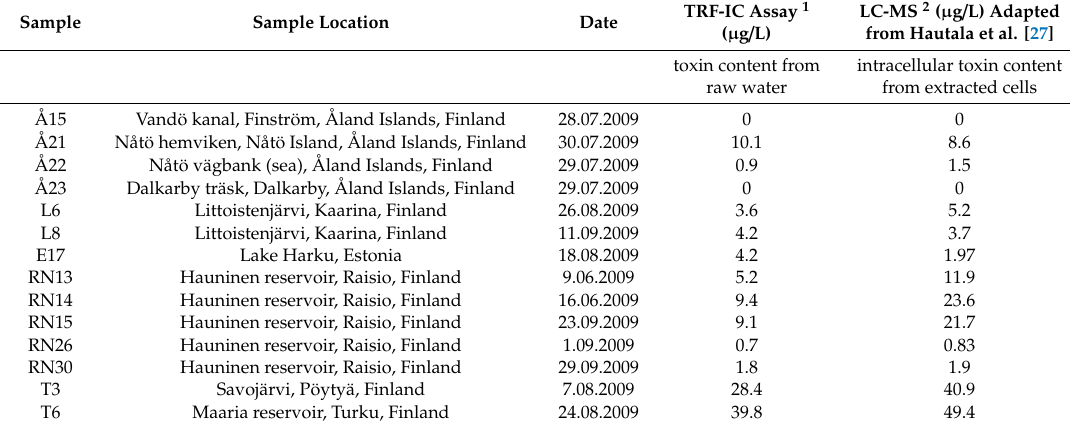
Table 1. Raw environmental samples used for the evaluation of the developed lateral flow strips assay. The corresponding toxin concentration as microcystin-LR equivalent by TRF-IC assay (raw water) and by reference LC-MS method (intracellular toxin from extracted cells) are shown.